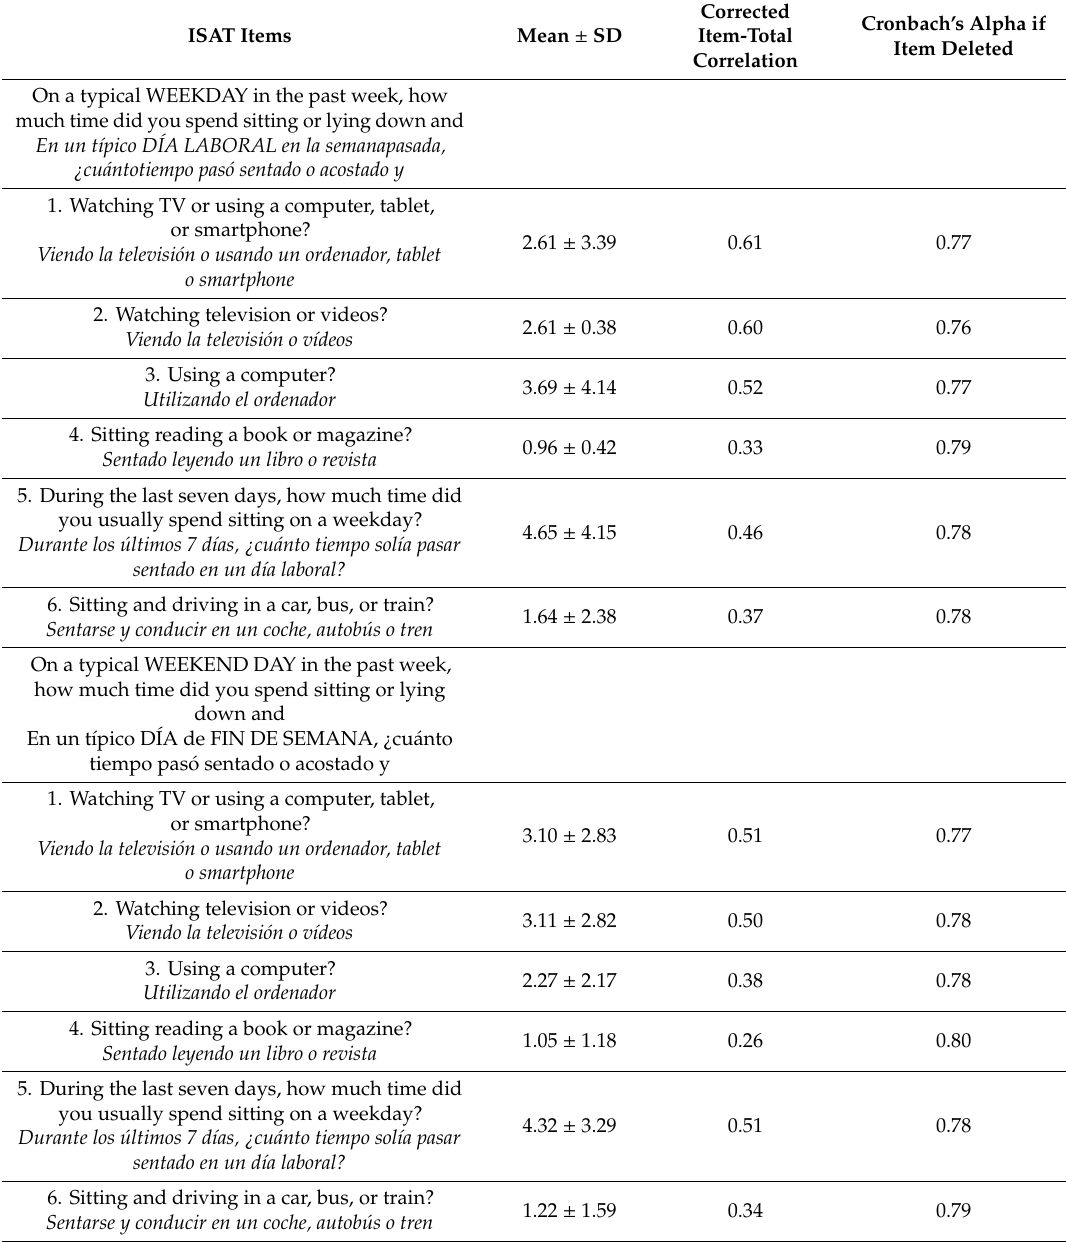
Table 2. Descriptive statistics and internal consistency for items from the